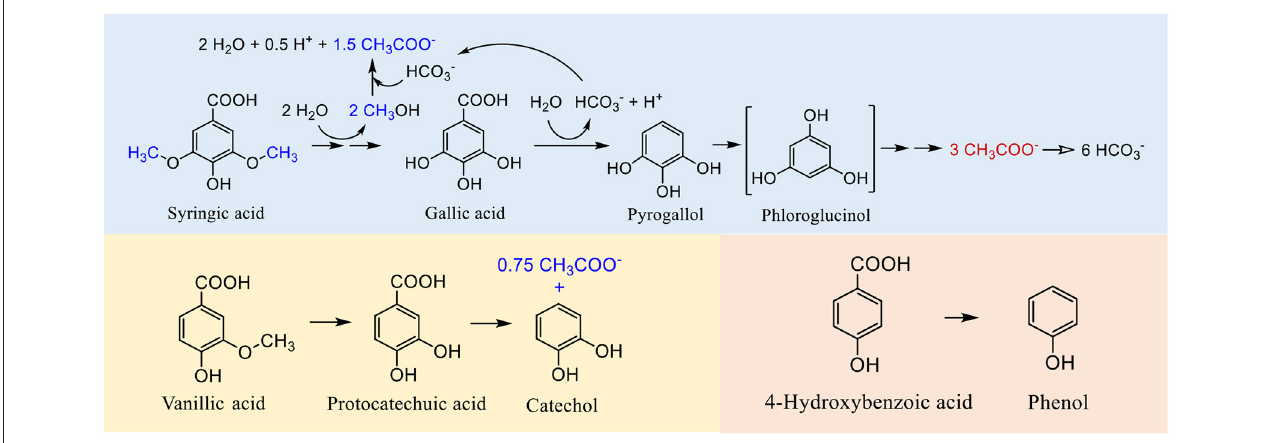
FIGURE 7 | Biotransformation pathways of syringic acid, vanillic acid, and 4-hydroxybenzoic acid. Different amounts of acetate were produced from these compounds as shown in the acetate-producing reactions (drawn based on material presented in Zeng et al., 2017).